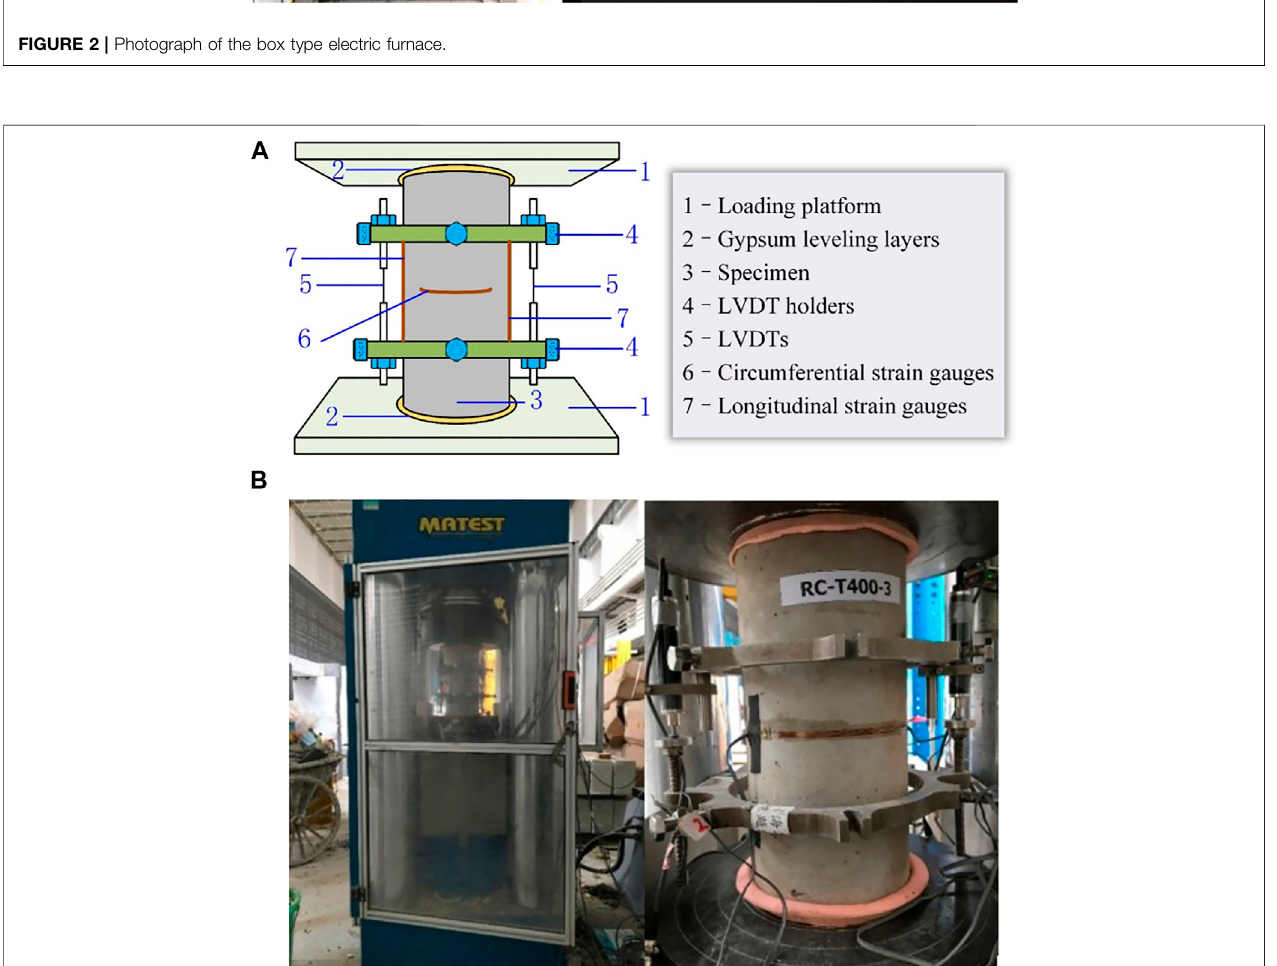
FIGURE 3 | (A) Schematic diagram and (B) Test photo of the compression